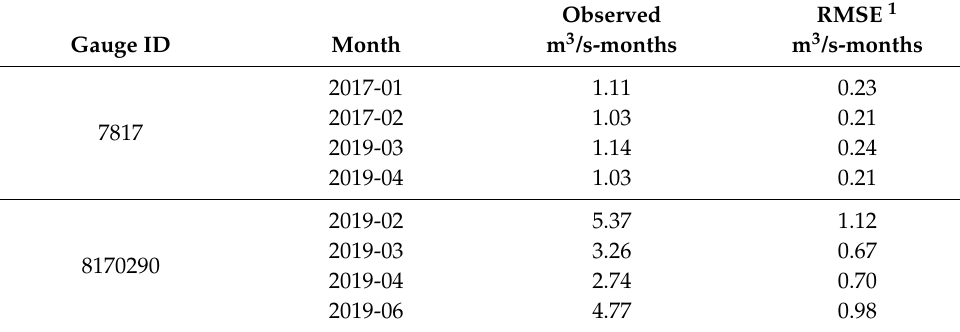
Table 7. Listing of discharge target, prior-data